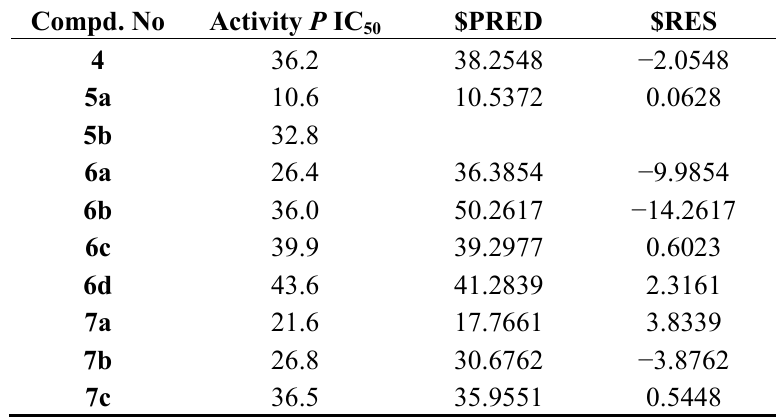
Table 4. Experimentally observed, predicted activity of the new compounds and their